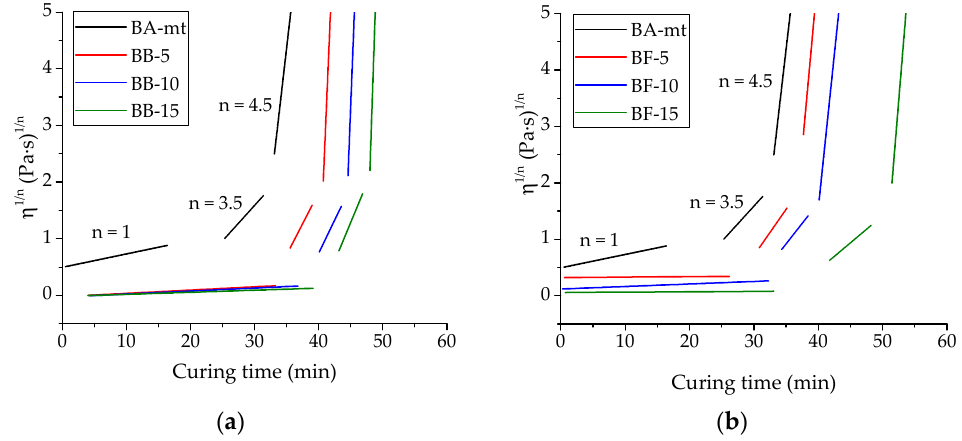
Figure 9. Dependencies of viscosity on curing time in the coordinates of the modified Malkin–Kulichikhin equation at 180 °C for compositions with BD ( a ) and with FUR ( b ). Table 5. The characteristic times of the process of structuring for compositions under study. Formulation